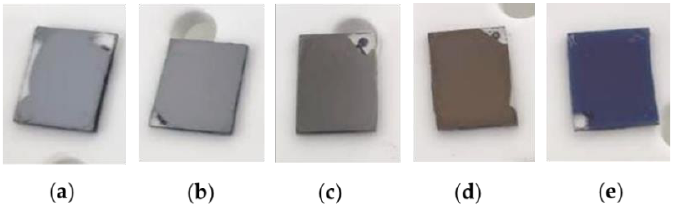
Figure 3. Photographs of: ( a ) pristine MAPbI 3 film; samples obtained by the plasma deposition of the fluorocarbon coating performed for ( b ) 10 s, ( c ) 30 s, ( d ) 60 s and ( e ) 120 s on the perovskite.